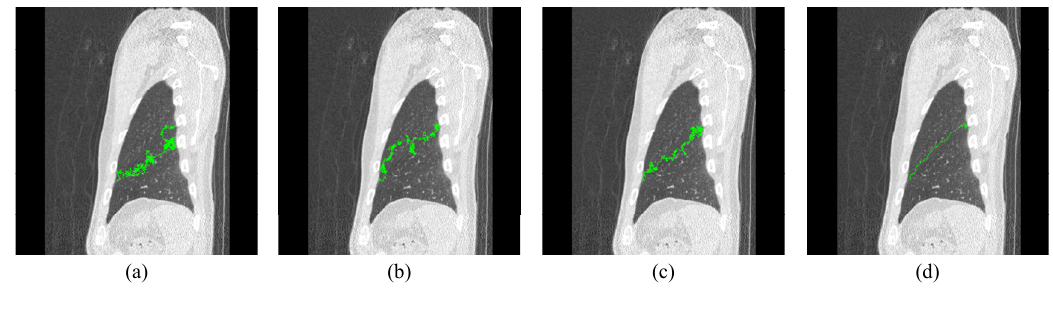
Figure 9. The second example for optimal path of ant movement with N = 10, where (a) R = 1; (b) R = 2; (c) R = 3; and (d) R =